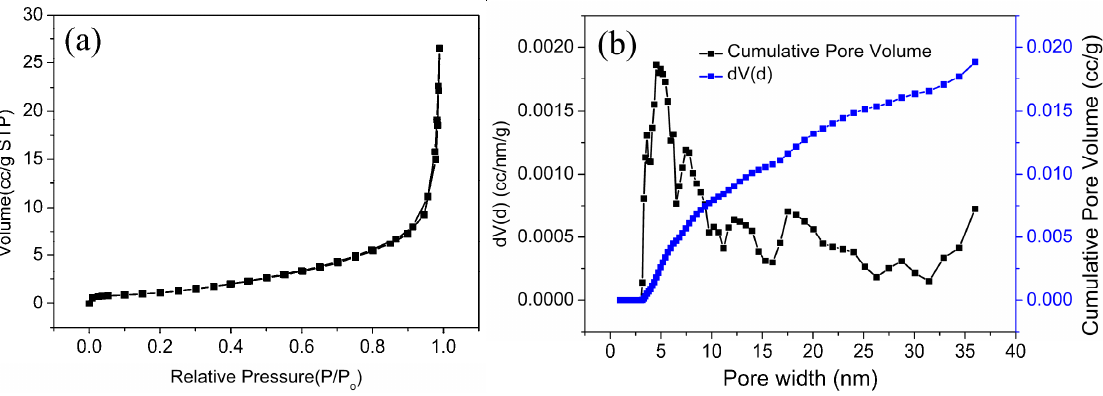
Figure 4. ( a ) Nitrogen adsorption-desorption isotherm and ( b ) pore size distribution. To further investigate the chemical composition and surface characteristics of the material, rGO-coated CuFeO 2 was analyzed by XPS, and the distinct peaks allocated to elements C, Fe, Cu, and O were discovered in Figure 5a. C 1s spectra were illustrated